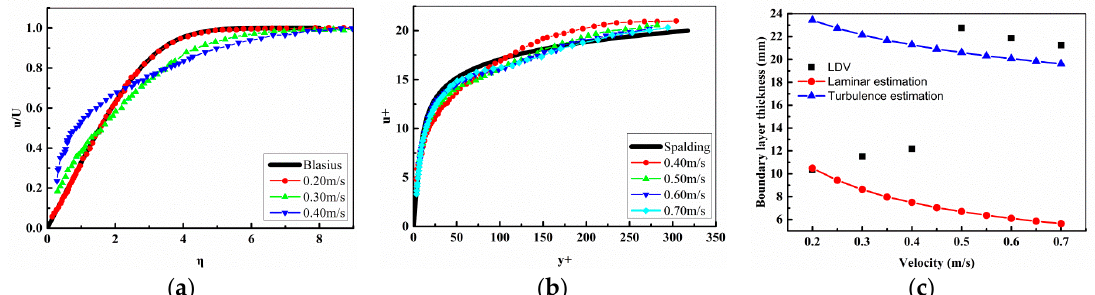
Figure 10. ( a ) Velocity profiles obtained by Laser Doppler Velocimetry (LDV) compares with laminar Blasius velocity profile. ( b ) Velocity profiles obtained by LDV compares with turbulent Spalding velocity profile. ( c ) Boundary layer thickness calculated by velocity profiles compared with laminar and turbulence empirical formulas values. Table 4. Boundary layer thickness and shear stress measured by LDV.